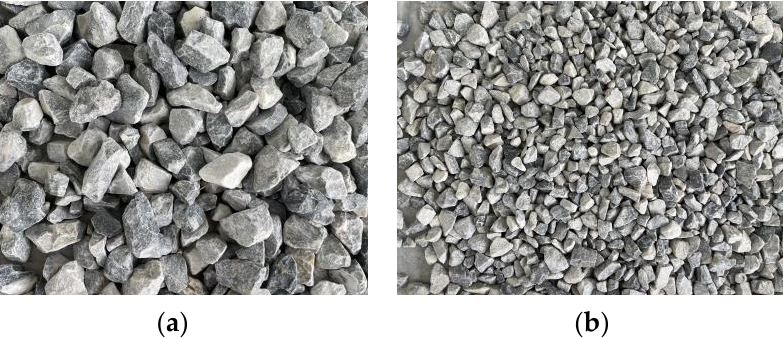
Figure 5. Appearance of the used coarse aggregate: ( a ) particle size in 10 – 25 mm; ( b ) particle size in 5 – 10 mm.